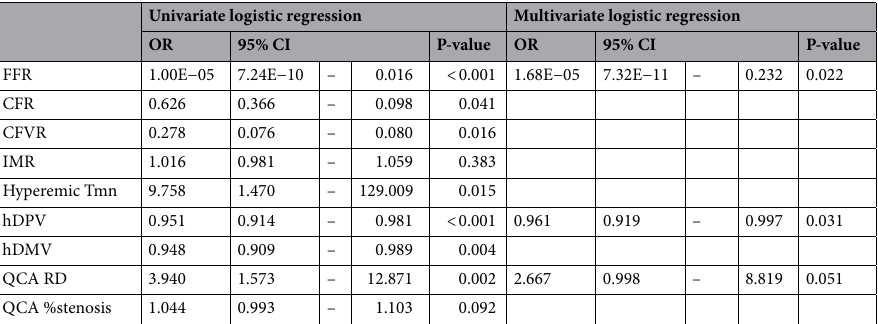
Table 2. Univariate and multivariate analysis predicting a significant coronary flow increase. CFR coronary flow reserve, CFVR coronary flow velocity reserve, FFR fractional flow reserve, hDMV hyperemic diastolic mean velocity, hDPV hyperemic diastolic peak velocity, IMR index of microcirculatory resistance, %stenosis percent diameter stenosis, QCA quantitative coronary angiography, RD reference lumen diameter, Tmn transit time.